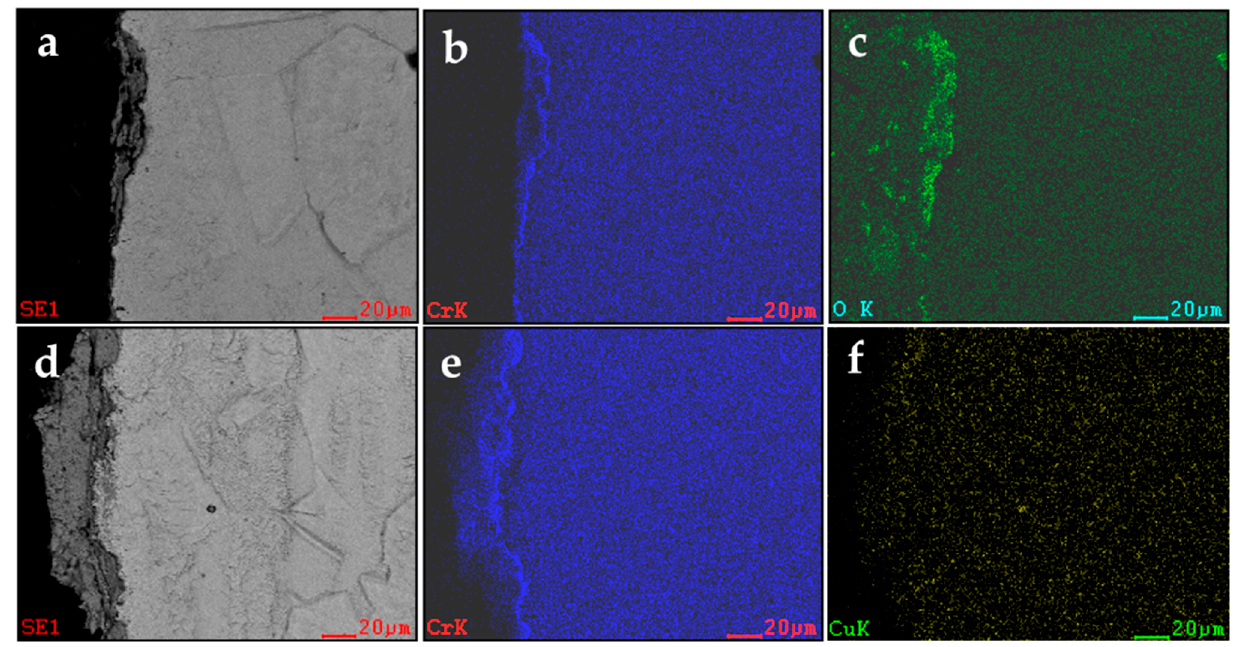
Figure 8. SEM photo of the protective film on the steel surface and the scanning of main elements: ( a – c ) for 301 ASS and ( d – f ) for 301ASS-0.4Cu.